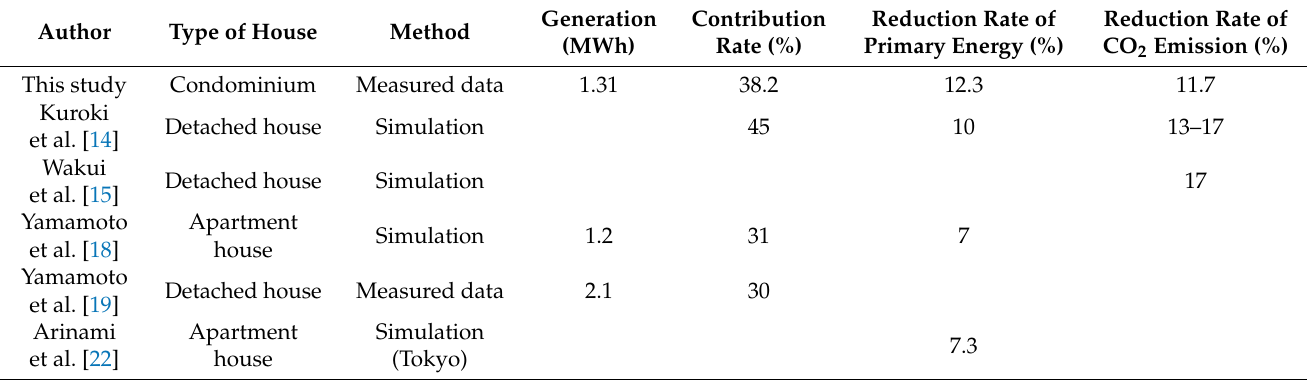
Table 6. Annual effect values of cogeneration system (CGS) in previous